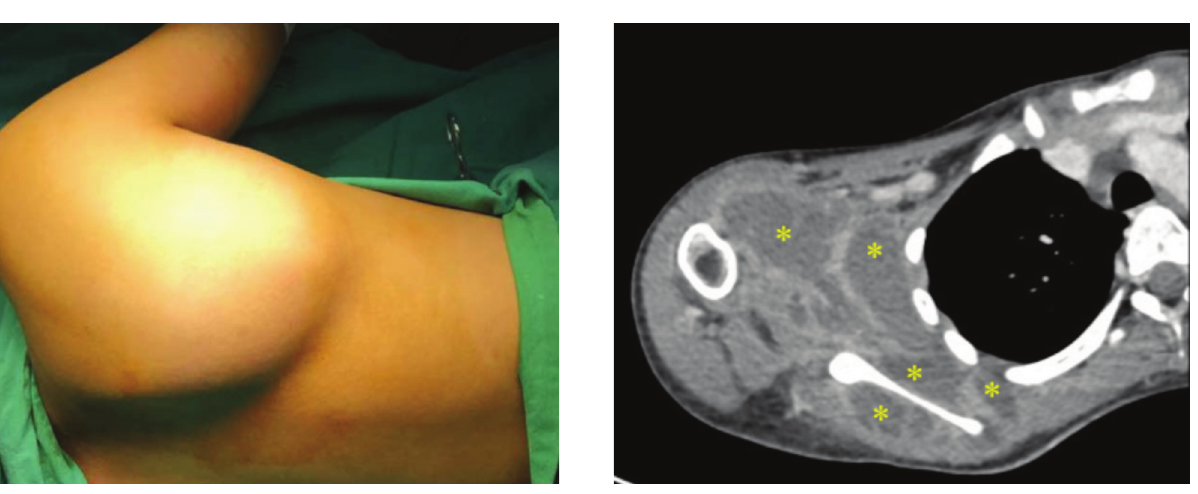
Computer Tomographic scan revealing multiloculate Fig. 2: intramuscular abscess (yellow *) at right anterior and posterior scapula extending into axillary region in the axial